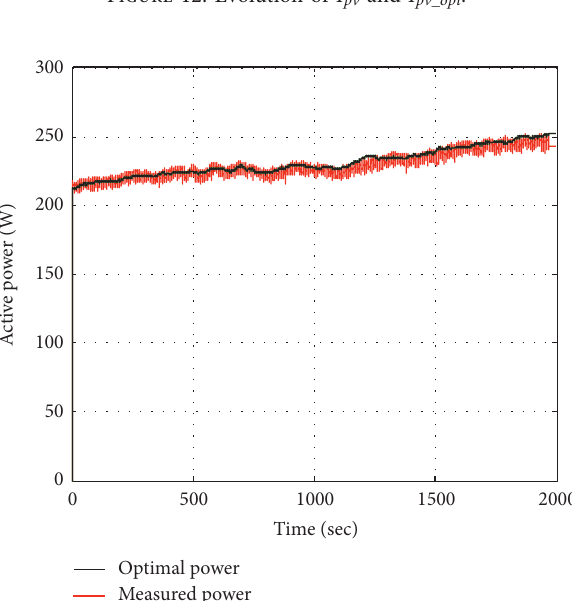
Figure 12: Evolution of I